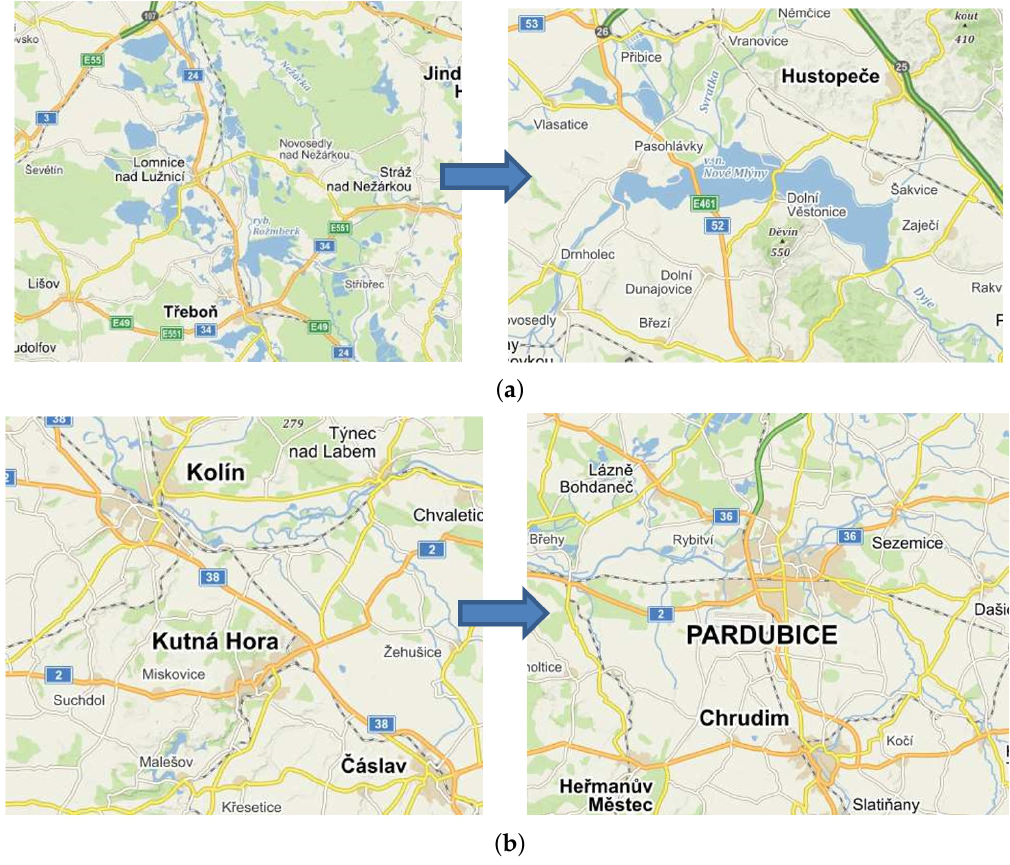
Figure 5. Two pairs with similar maps: ( a ) neighbor maps with water bodies; ( b ) neighbor maps with first and second class roads (extracts are author’s work from portal: https: // mapy.cz, accessed 10 September 2019).